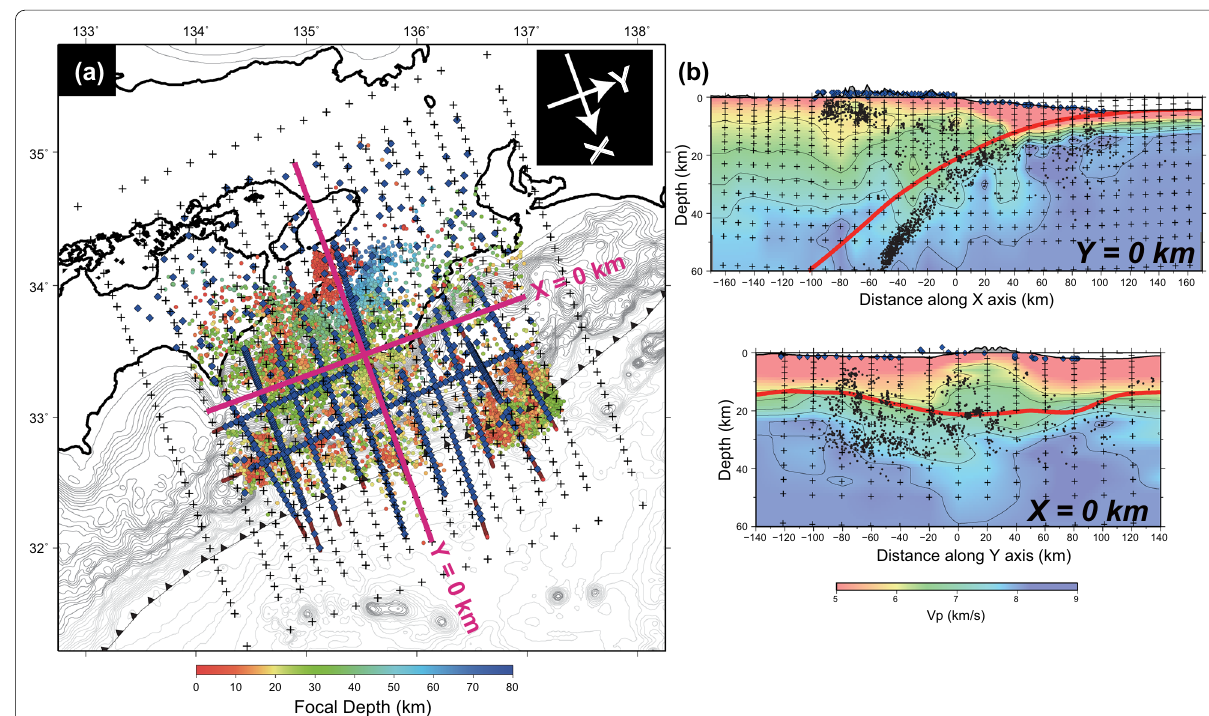
Fig. 3 Tomographic inversion settings. a Crosses, blue diamonds, and colored circles reflect the horizontal distribution of grid nodes for the velocity model, stations, and initial hypocenters, respectively. b Initial P-wave velocity model along trough-normal profile at Y profile at X 0 km. Initial hypocenters are shown as black dots. Red line is the plate boundary of Nakanishi et al. (2018). Thin black lines are P-wave = velocity contours between 6 and 8 km/s (0.5 km/s increment). Vertical exaggeration